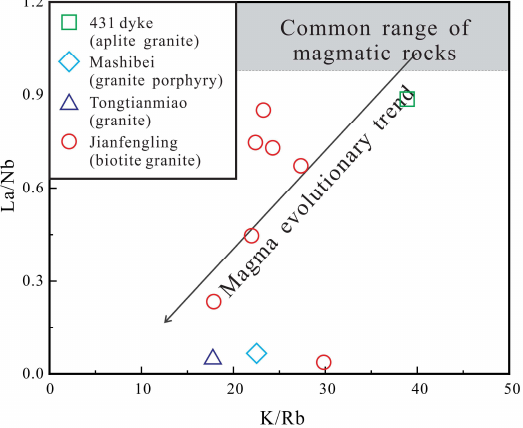
Figure 15. Evolution trend of K/Rb vs. La/Nb magma in the Xianghualing ore field.